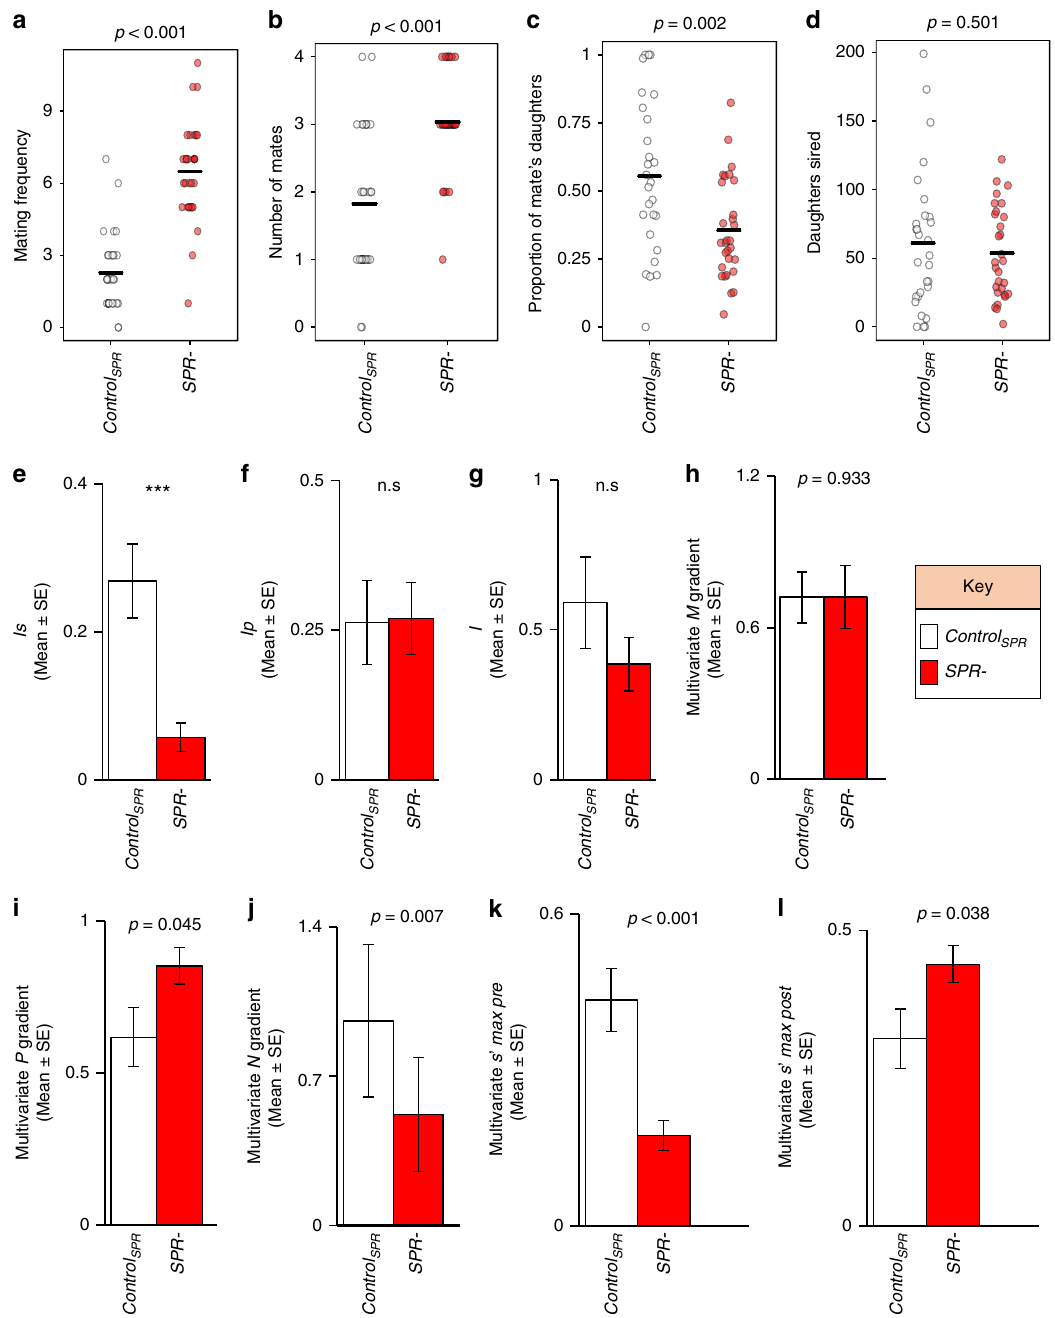
Fig. 2 SPR effects on polyandry and the operation of sexual selection on males. a Focal male total mating frequency. b Focal male mating success (number of unique mates); c proportion of mate ’ s daughters sired by focal males; d total number of daughters sired by the focal males; e the standardised variance in focal male mating success ( I S ) (the opportunity for pre-copulatory sexual selection), ***: non-overlapping 95% bootstrap con fi dence interval; f the standardised variance in focal male siring success (opportunity for post-copulatory sexual selection, I P ), n.s.: overlapping bootstrap con fi dence intervals; g the standardised variance in offspring (daughters) sired by the focal males (opportunity for selection, I ), n.s.: overlapping bootstrap con fi dence intervals; h the multivariate gradient of focal male mating success ( M ) on reproductive success ( T ); i the multivariate gradient of focal male paternity share ( P) on reproductive success ( T ); j the multivariate gradient of the productivity ( N ) of the mates of focal males and reproductive success ( T ); k the maximum standardised multivariate pre-copulatory sexual selection differential index (multivariate s ’ max (pre)); l the maximum standardised multivariate post- copulatory sexual selection differential index (multivariate s ’ max (post)). Sample sizes: N = 27 for control SPR and N = 29 for SPR − treatment. a – d Horizontal black line represents the mean of the data; p values were obtained from F tests from GLM models. e – l Error bars in refer to the standard error of the mean (SE). Note the differences in scale of the y axis in each panel. White colour refers to control SPR treatment; red colour refers to the SPR − treatment. h – l P values obtained from Student's t tests from multivariate linear